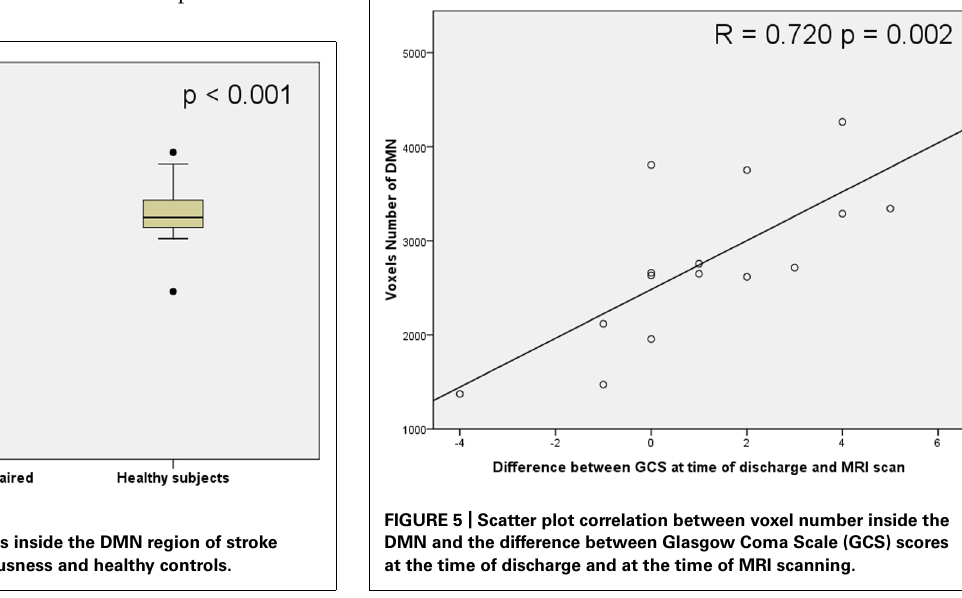
FIGURE 3 | Spatial maps of 7 RSNs in normal controls and stroke patients with impaired consciousness. The first two rows show the result of one sample t -test of each RSN from both groups ( p < 0.05). The last row shows the two sample t -test result of the left executive